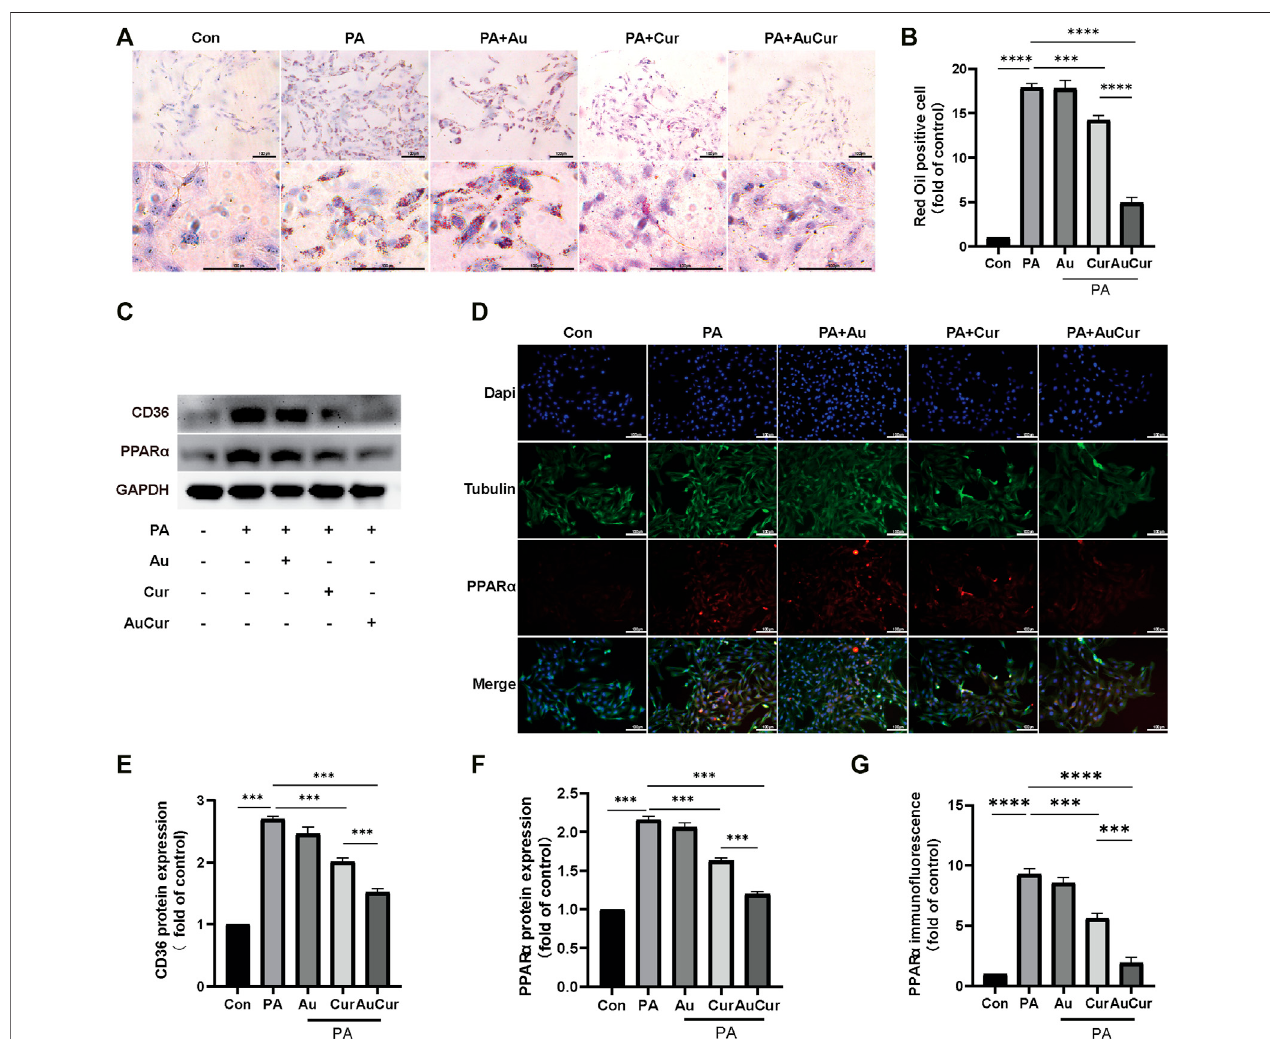
FIGURE3| AuCurwasmoreeffectiveinreducinglipidaccumulationthanCuralone. (A) MyocardialH9C2cellswerestainedwithoilredOtreatedwithControl,PA, PA + Au, PA + Cur ,and PA + AuCur, respectively. Scale bar: 100 μ m. (C) The expression of CD36 and PPAR α was detected by WB. GAPDH was used as an internal reference. (D) PPAR α fl uorescence images of Control, PA, PA + Au, PA + Cur, and PA + AuCur groups. (B) Oil red O lipid droplet analysis. (E – F) WB band analysis. (G) PPAR α fl uorescence quantitative analysis. Scale bar: 100 μ m * p < 0.05.